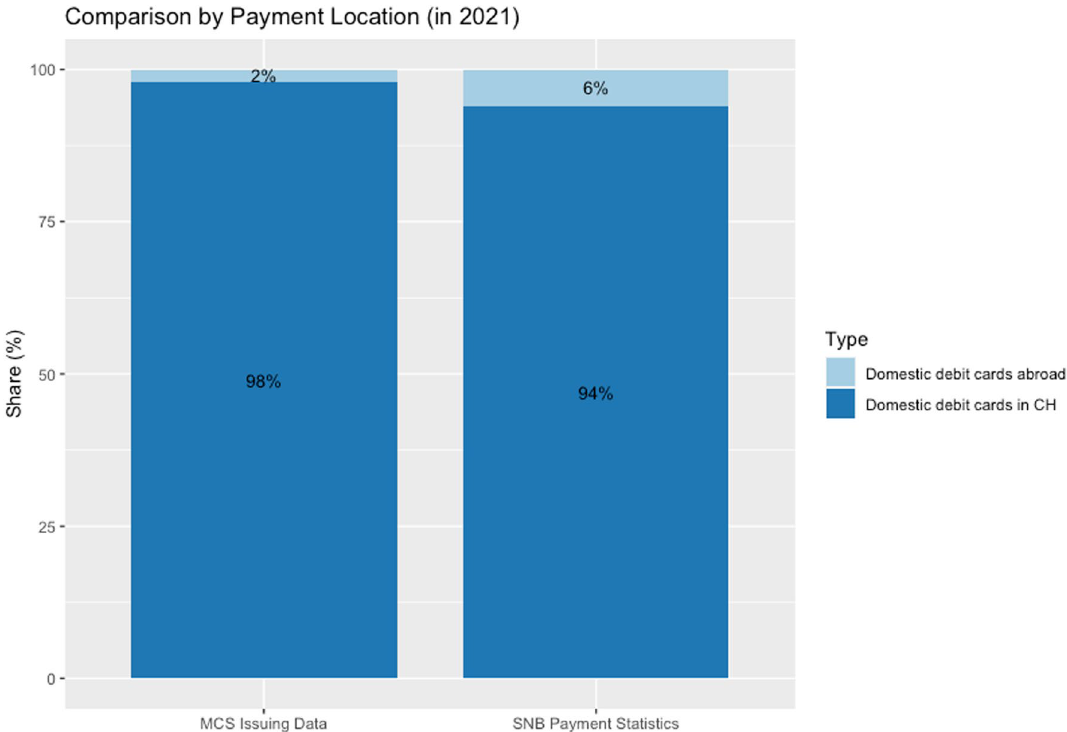
Fig. 6 Comparison of MCS issuing data to SNB payment statistics, 2021. Note : The figure displays the location of debit card transactions in the issuing data against the location of debit card transactions according to SNB. Data source: MCS_Overview_Data.csv, SNB «Payment and Cash Withdrawals.» (https:// data. snb. ch/ en/ topics/ finma/ cube/ zavez aluba)